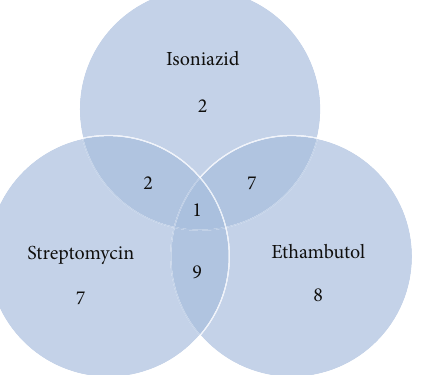
Figure 2: Resistance to isoniazid, ethambutol, and streptomycin.